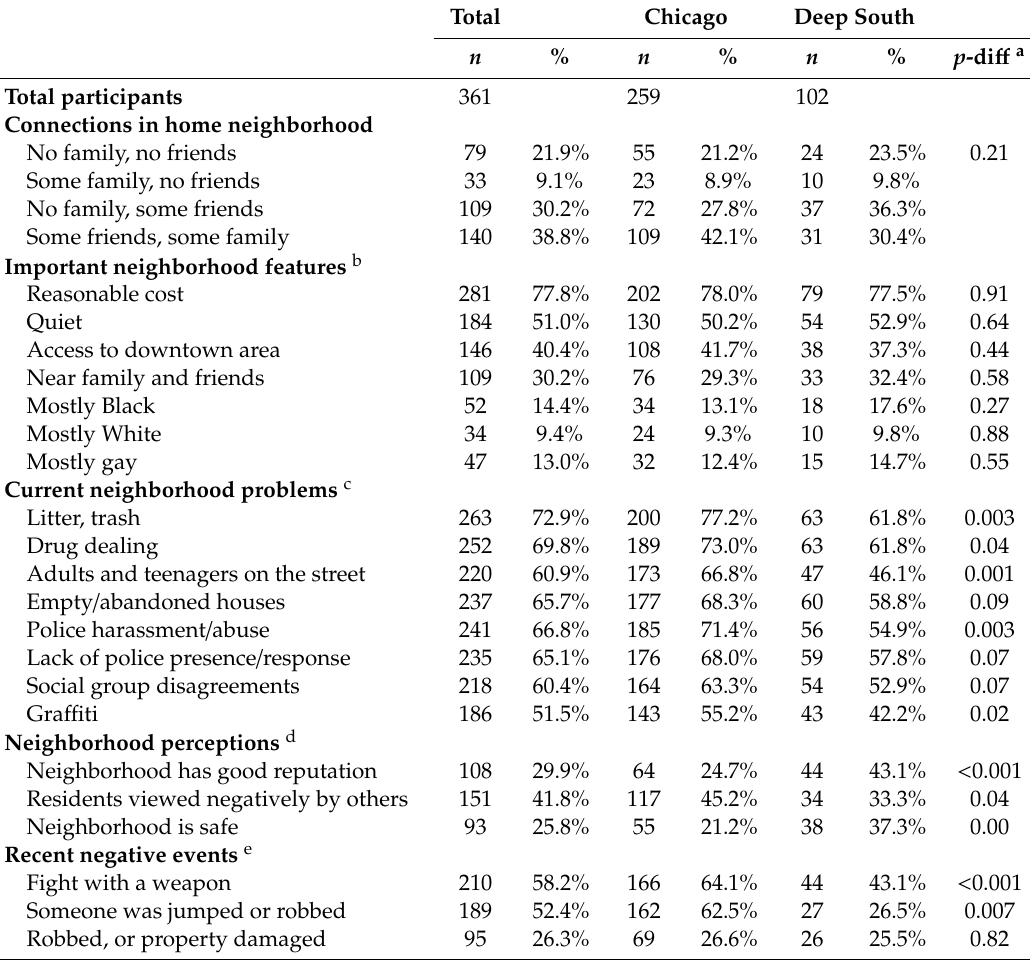
Table 4. Neighborhood characteristics at baseline among cisgender Black gay, bisexual, and other men who have sex with men participating in the Neighborhoods and Networks (N2) Cohort Study , enrolled as